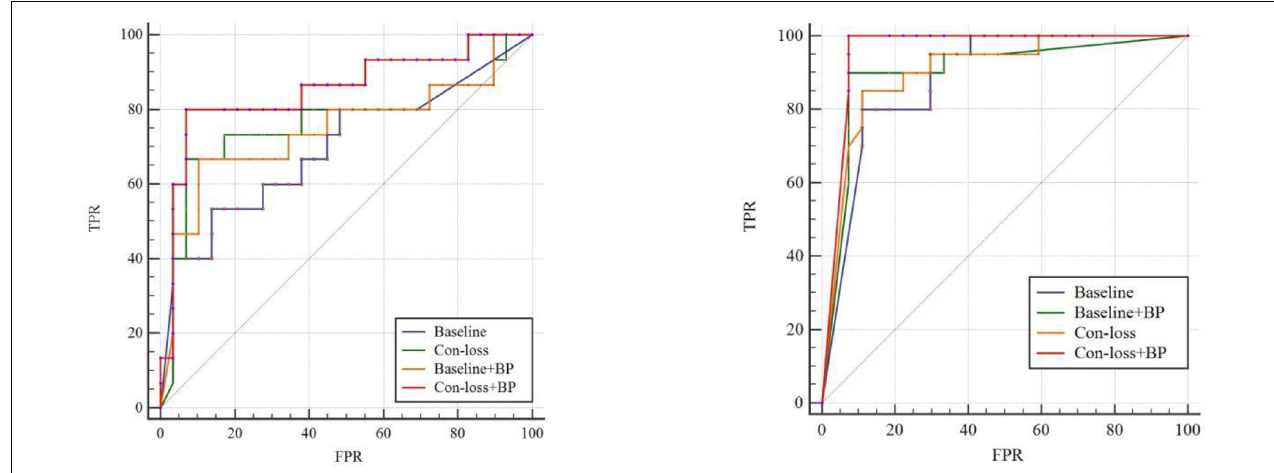
FIGURE 3 | Receiver operating characteristic (ROC) curves of experiments for EMCI vs. LMCI classification and the ROC of experiments for NC vs. AD classification based on the Schaefer et al. (2018) atlas. TPR, true positive rate; FPR, false-positive rate; AUC, area under the receiver operating characteristic curve. Please see the web version for the complete colorful